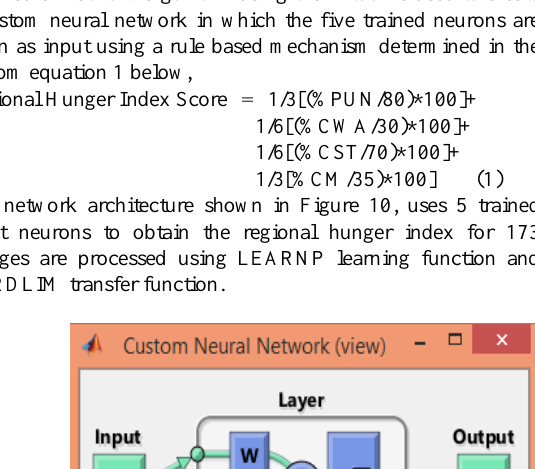
Figure 5. SOM neighbour weight distance Figure 6. Sample hits